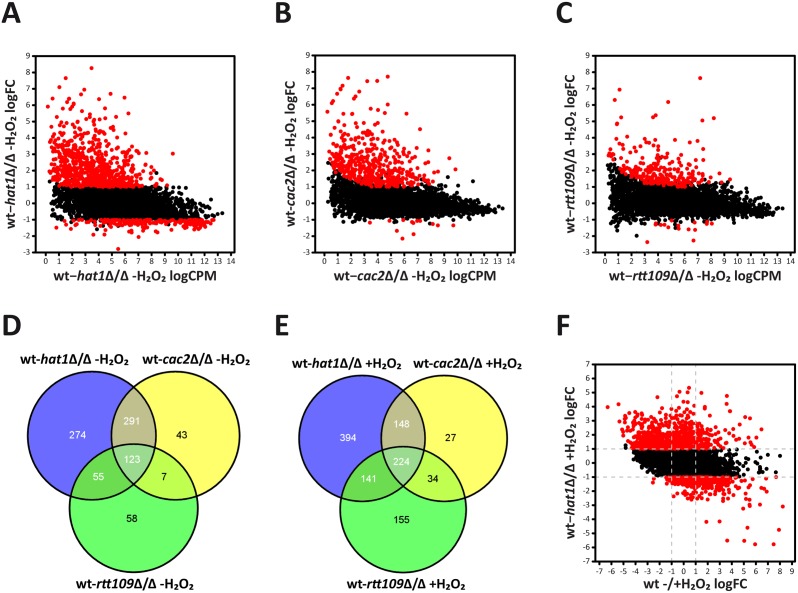
Deletion of HAT1 primarily leads to upregulation of genes.(A) Lack of Hat1 causes mainly induction of genes in logarithmically growing cells. Each dot corresponds to one protein-coding gene. The fold change in RNA expression between untreated wild-type and hat1Δ/Δ cells (y-axis) is plotted against the expression level of each gene in this dataset (x-axis). Differentially expressed genes in the hat1Δ/Δ mutant are depicted in red. logCPM: log2 counts per million reads; logFC: log2 fold change; (B+C) Loss of Cac2 or Rtt109 causes almost exclusively upregulation of genes in logarithmically growing cells. Plots were created as described in (A). (D) Venn diagram showing the overlaps of upregulated genes in the hat1Δ/Δ, cac2Δ/Δ and rtt109Δ/Δ mutants in the absence of H2O2. (E) Venn diagram showing the overlaps of upregulated genes in the hat1Δ/Δ, cac2Δ/Δ and rtt109Δ/Δ mutants upon treatment with H2O2. (F) H2O2 repressed genes are upregulated in the hat1Δ/Δ mutant upon peroxide treatment. Each dot corresponds to one protein-coding gene. The -fold change in RNA expression between H2O2 treated wild-type and hat1Δ/Δ strains (y-axis) is plotted against the fold change between the wild-type without and with treatment (x-axis). Differentially expressed genes in the hat1Δ/Δ mutant are depicted in red. logFC: log2 fold change; (A-F) Differentially regulated genes were defined by a fold change > = 2 and p-value <0.05.